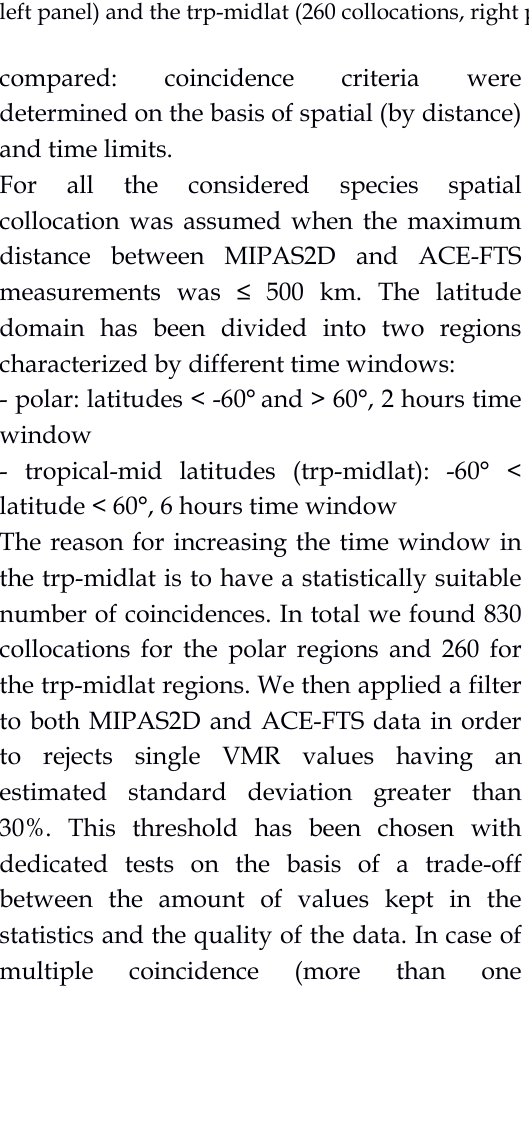
comparison: the red dots represents the geolocation of MIPAS2D data and the blue dots the geolocations of ACE